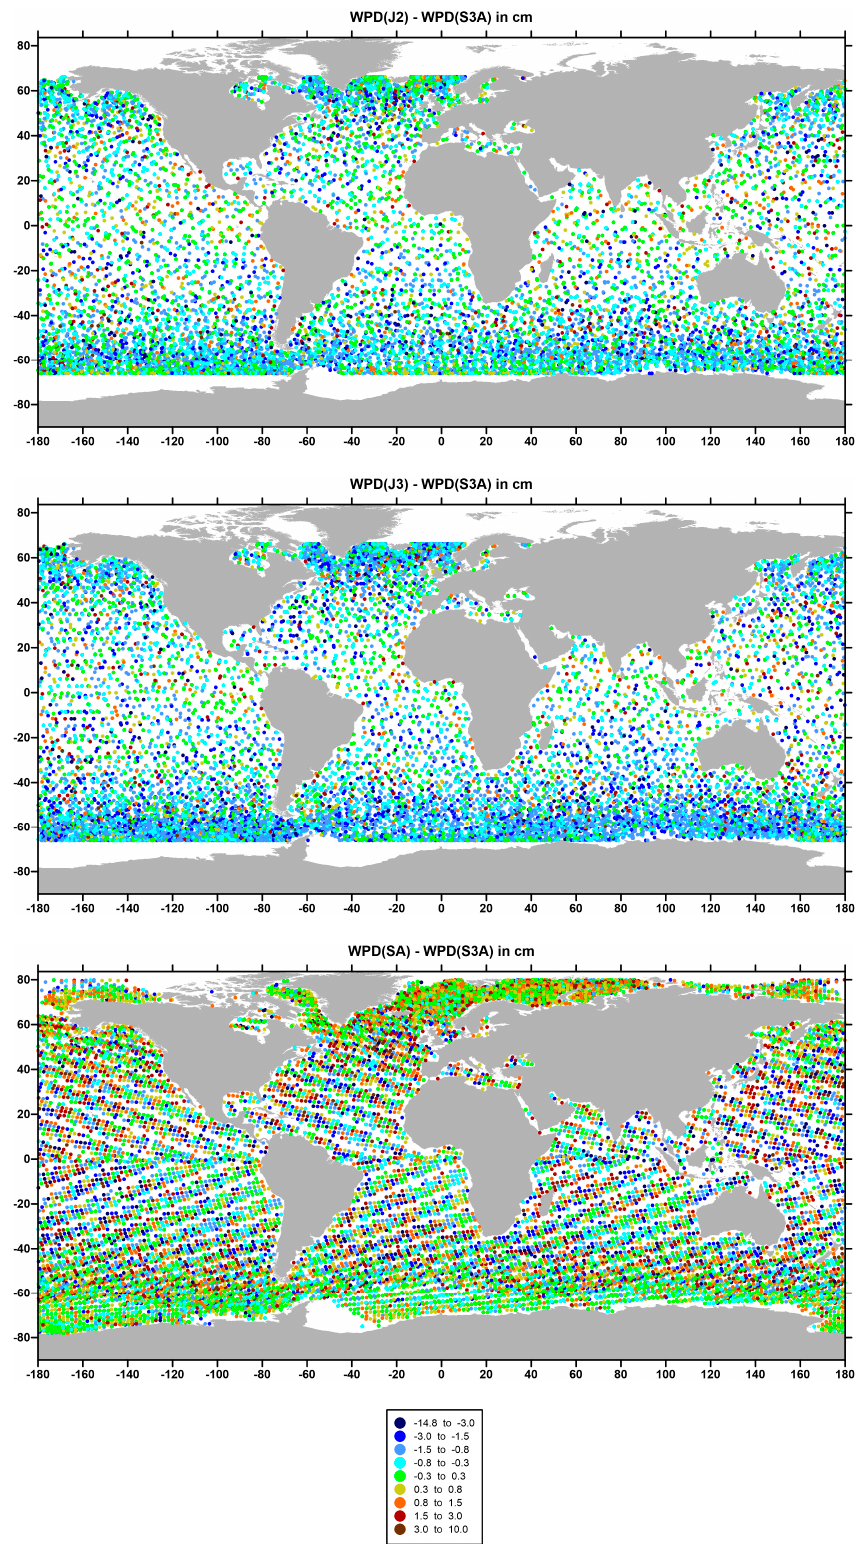
Figure 8. ( Top panel ): Crossover points between J2 and S3A with Δ T < 180 min (~11,600 points); ( Middle panel ): crossovers between J3 and the S3A with Δ T < 180 min (~12,600 points); ( Bottom panel ): crossovers between SARAL and S3A with Δ T < 240 min (~13,700 points).